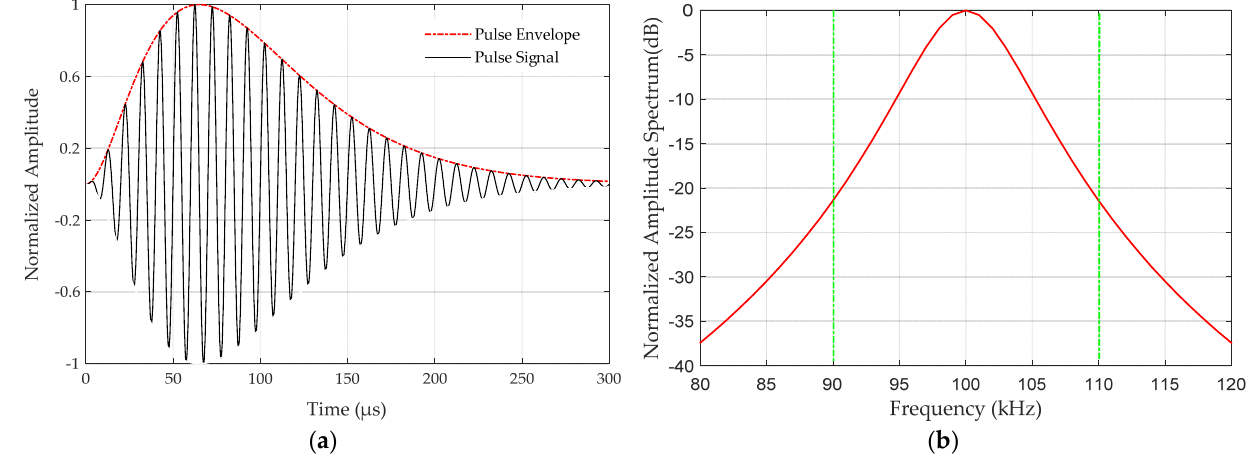
Figure 1. Characteristics of a single eLoran signal: ( a ) eLoran pulse signal; ( b ) eLoran signal amplitude spectrum.